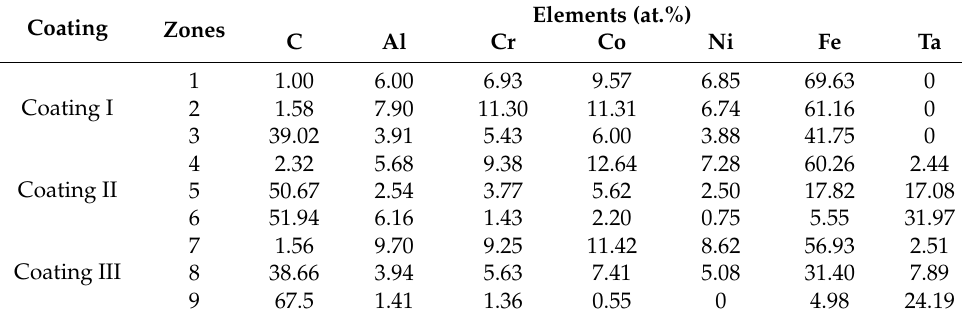
Table 2. Chemical compositions of marked zones shown in Figure